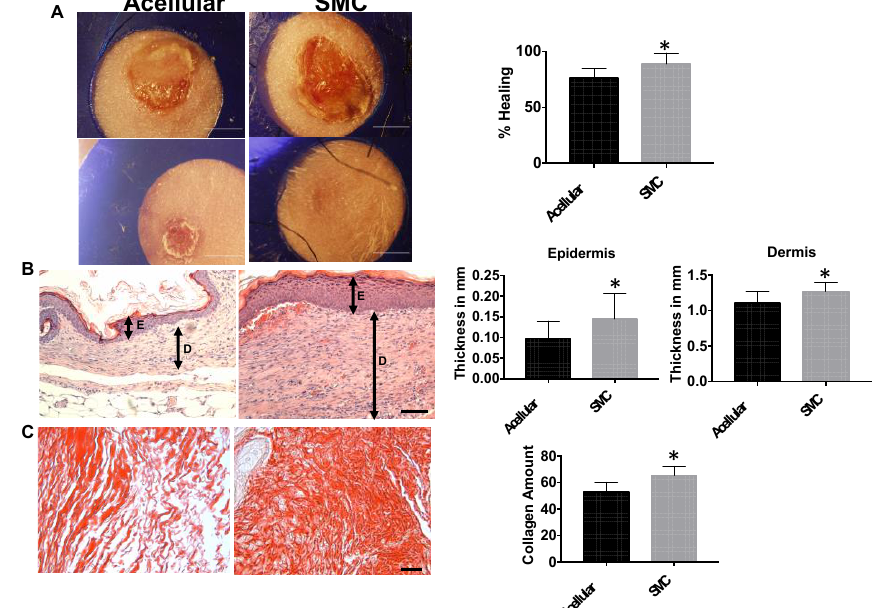
Figure 7. hiPSC-VSMCs in a rolled DC sca ff old promotes wound healing and in vivo cell survival. The hiPSC-VSMCs cultured in rolled sca ff olds for 72 h were implanted in splinted back wound in nude mice and were observed for 14 days. Acellular sca ff olds were used as control groups. ( A ) Gross morphology showing day 0 and 10 wound closure. The graph represents percentage wound closure of the treatment groups acellular and hiPSC-VSMC-based sca ff olds ( n = 9, hiPSC-VSMC vs. Acellular p < 0.01). ( B ) H&E images of regenerated skin showing epidermis and dermis of wounds treated with acellular and hiPSC-VSMC sca ff olds. The graphs represent the thickness of the epidermis ( n = 9, hiPSC-VSMC vs. Acellular p < 0.006) and dermis ( n = 9, hiPSC-VSMC vs. Acellular p < 0.05). ( C ) Sirius Red staining of wound tissue showing collagen (Red). The graph represents the amount of collagen in the wounds treated with acellular and hiPSC-VSMC sca ff olds ( n = 7, hiPSC-VSMC vs. Acellular p < 0.006). Statistical significance was determined using the Student t -test. In vivo cell survival was characterized in the explanted tissue treated with hiPSC-VSMC sca ff olds. * denotes statistical